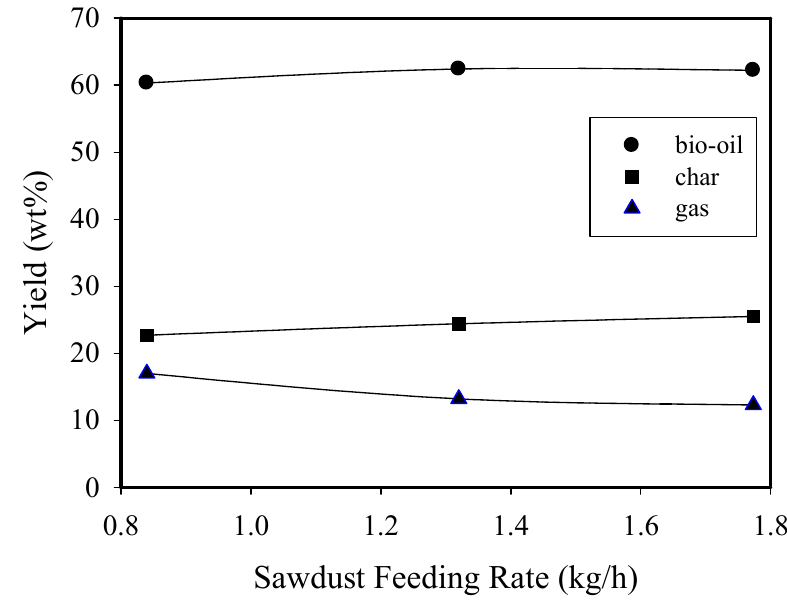
Figure 4. Effect of sawdust feeding rate on the product distribution for fast pyrolysis of wood sawdust (440 °C pyrolysis temperature, 15 L/min N 2 carrier gas flow rate).